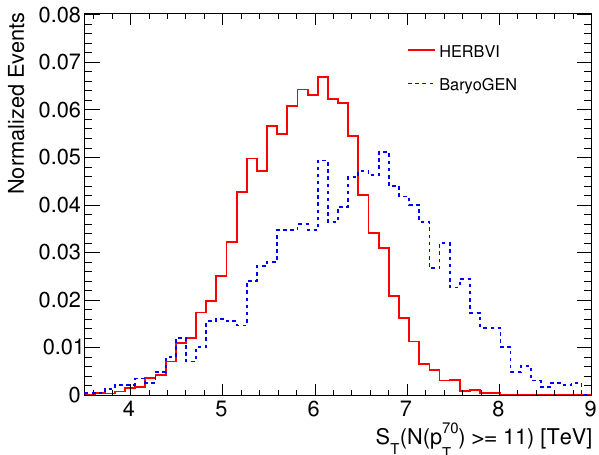
Figure 5 . The S T distribution with the condition N ( p T > 70) (cid:21) 11. The red-solid and blue-dashed histograms correspond to HERBVI and BaryoGEN event generators.